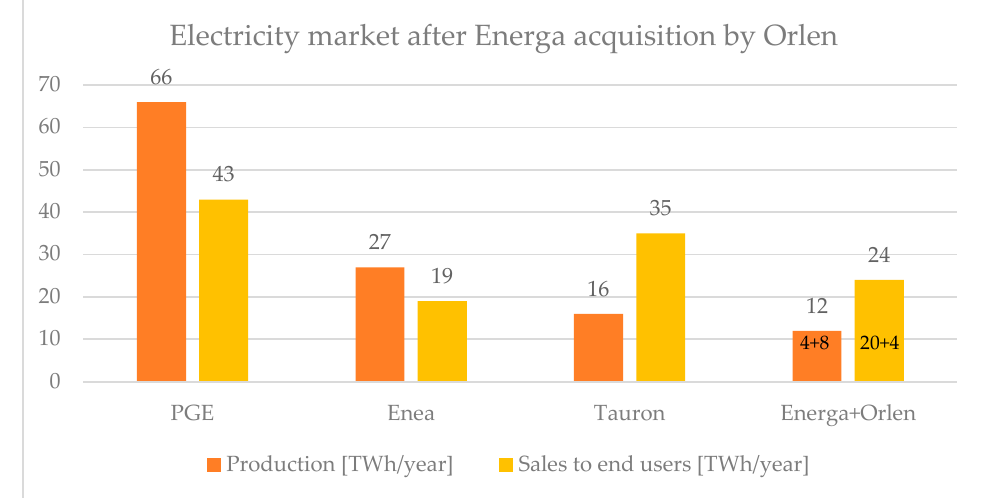
Figure 4. Electricity market after Energa acquisition by Orlen. Source: authors’ own studies, devel- oped from [55].